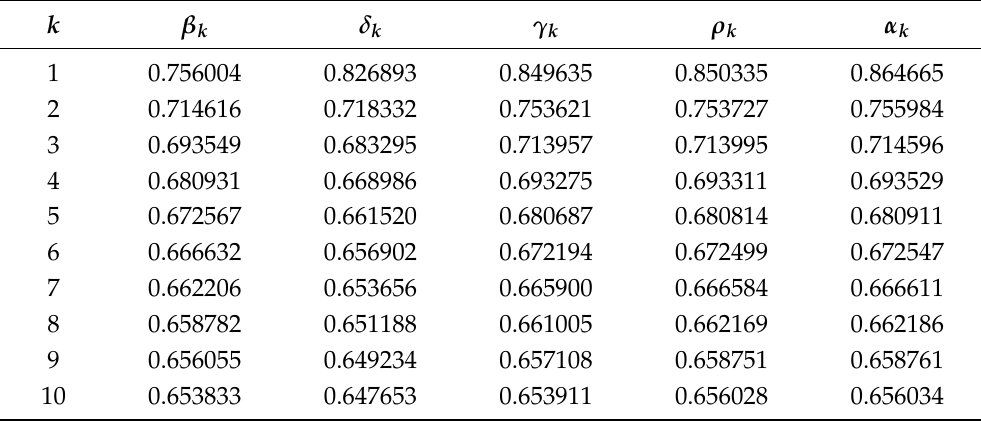
Table 1. Critical points: α k : Solution to P k ( x ) = Q k ( x ) , β k : Solution to D z R k ( x , z ) = 0, γ k : Solution